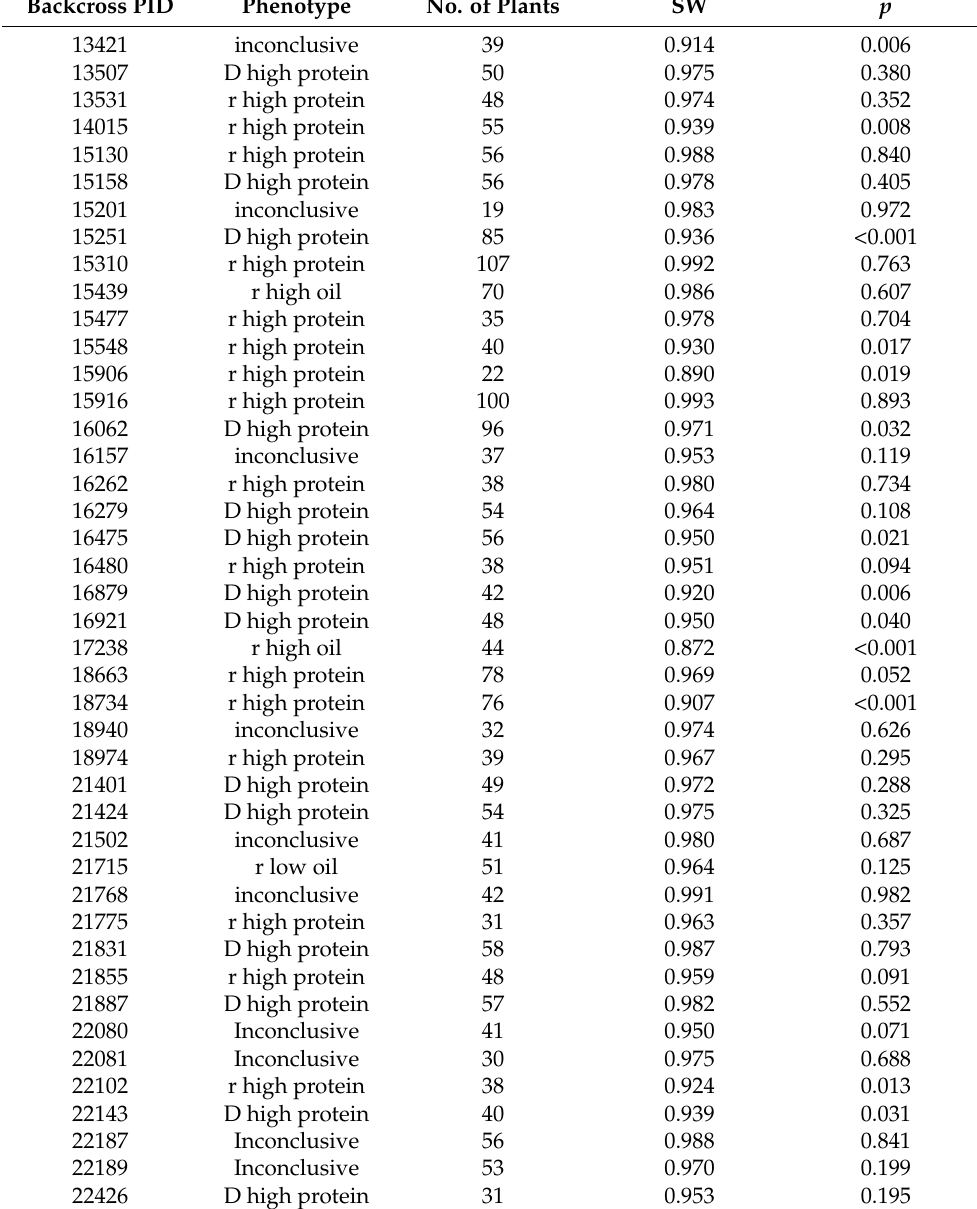
Table 1. Inheritance pattern of alleles for high protein from selected